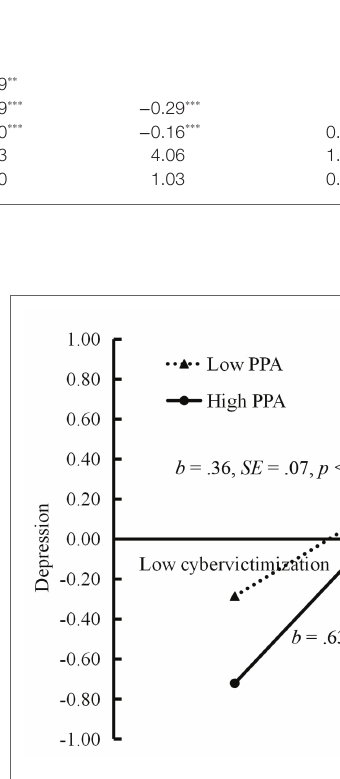
FIGURE 4 | Depression among adolescents as a function of cybervictimization and